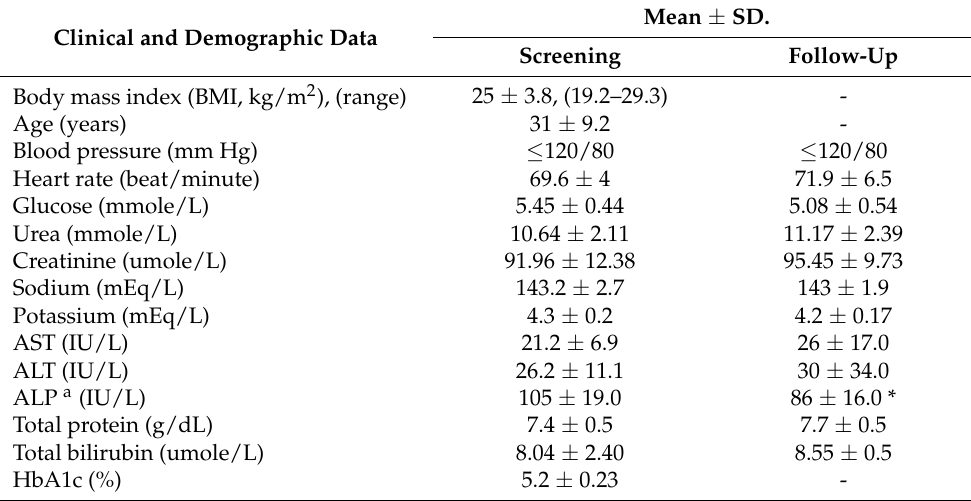
Table 1. Clinical and demographic data of recruited subjects ( n = 26 male) during screening and follow-up periods.